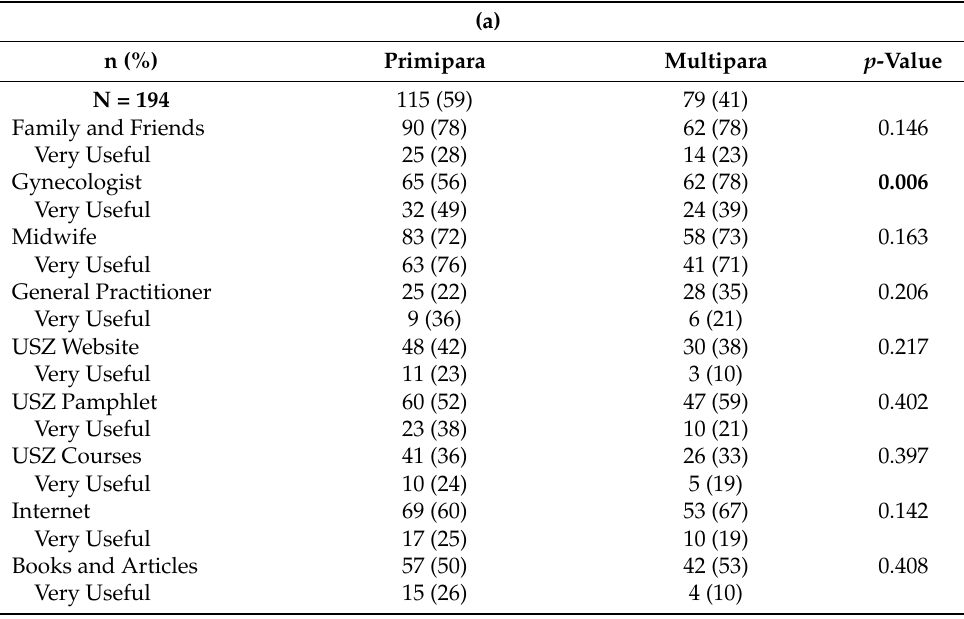
Table 4. (a) Consulted sources and their usefulness regarding the puerperium distinguished by number of births. (b) Consulted sources and their usefulness regarding the puerperium distinguished by educational level. Significant results are marked